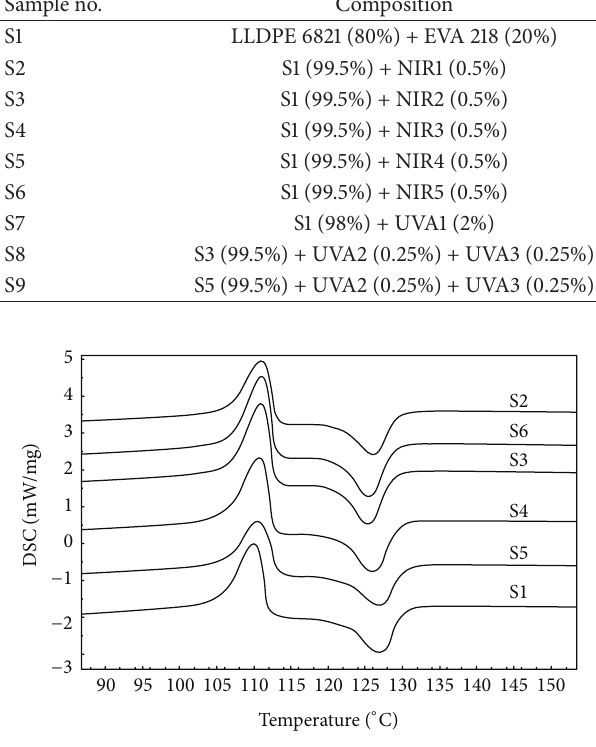
Table 4: List of the samples prepared and used this study. Sample no.